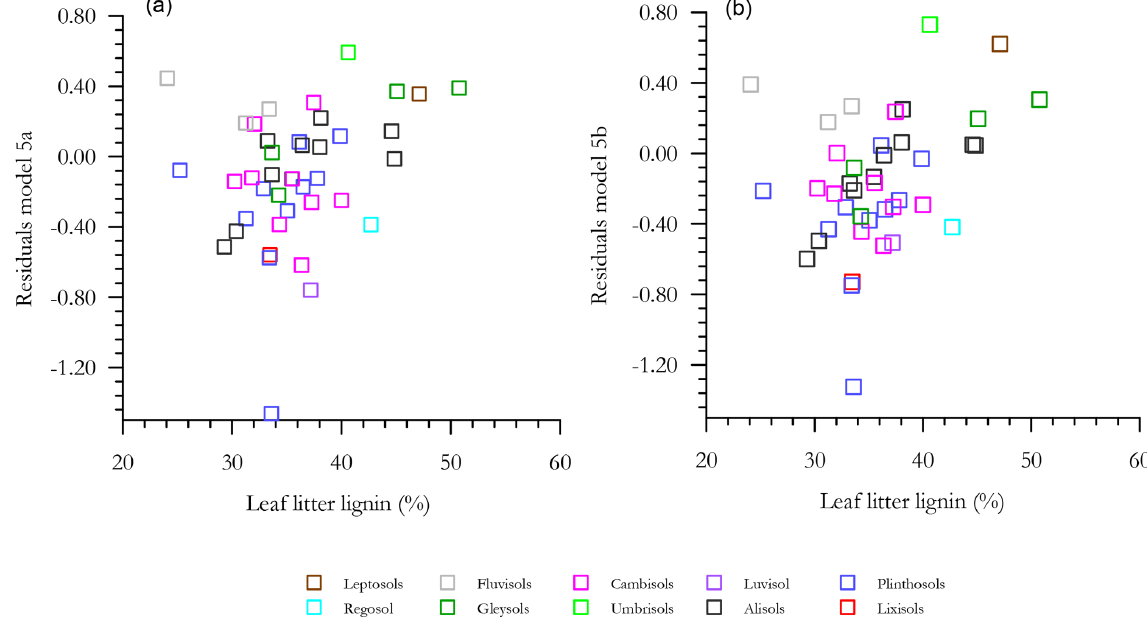
Figure 7. The effect of litter lignin content, a surrogate for the abundance of aromatic C compounds, on the residuals of model regressions in Table 6q (a) and a simplified additional model with only pH and Al d included (b) . Table 6. Summary of OLS regression coefficients for soil organic carbon in HAC soils. b SE